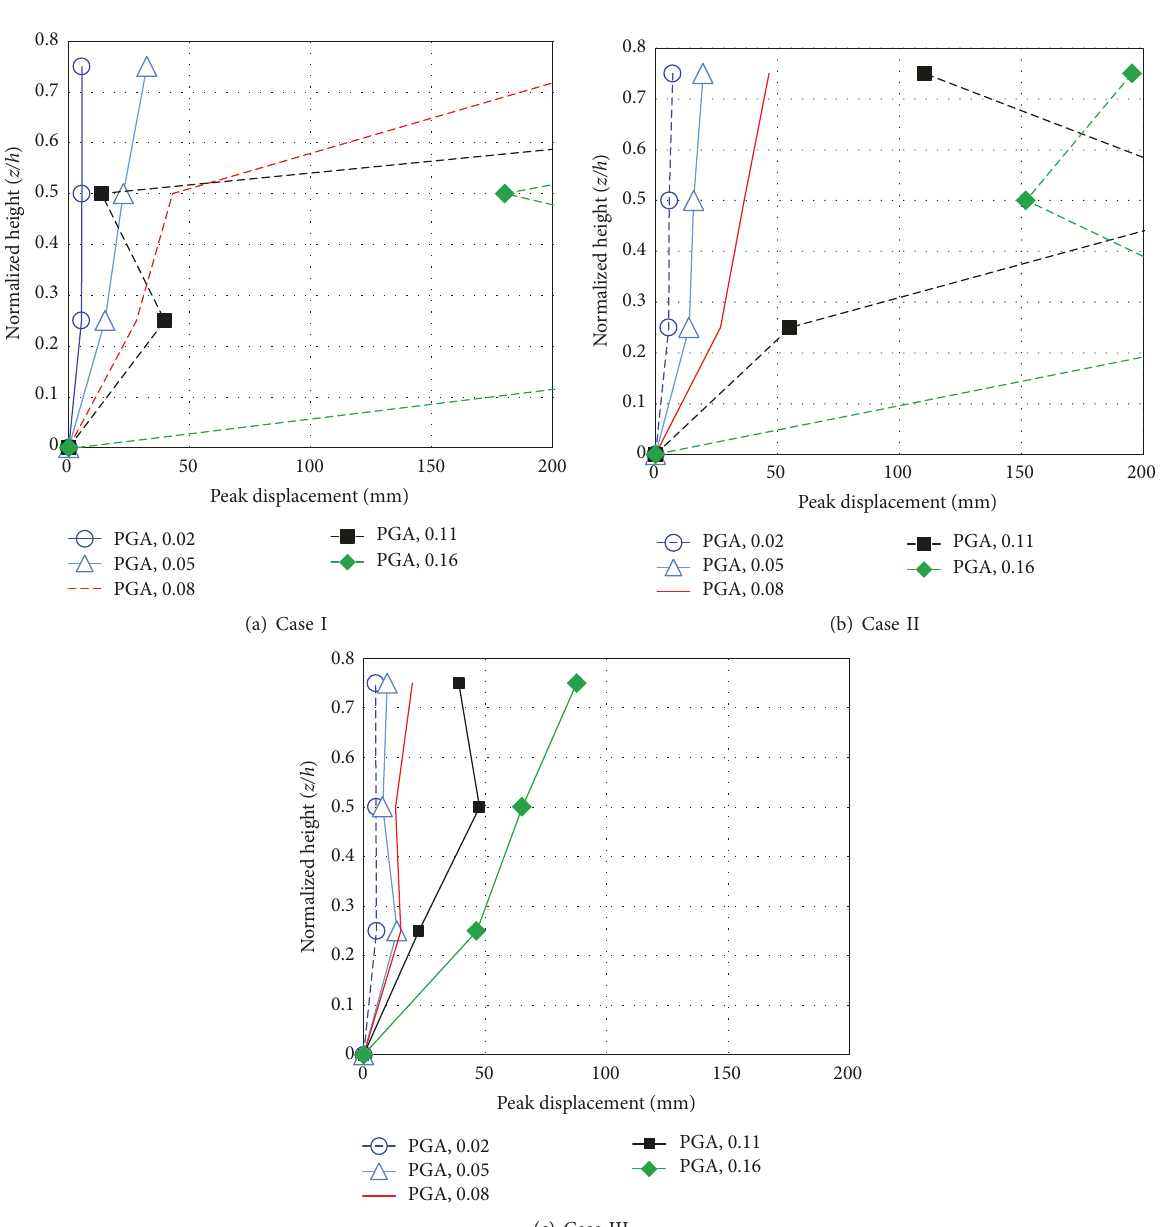
walls with vertical isolation only (Case III), the observed failure pattern is found to match the expected arching action reported by other researchers [12–14]. Similar results are observed for the walls with aspect ratios of 0.75 and